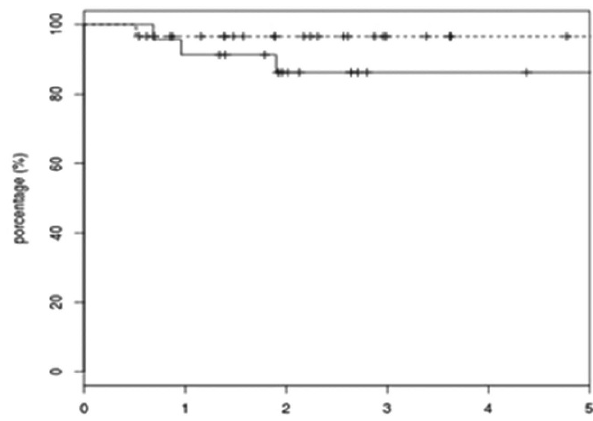
Figure 1 - Kaplan-Meier analysis of 5-year survival free of local recurrence comparing Pex (---) with Unpex (—). Pex: 96.5% 6 Unpex: 86.2% ( p =0.31).